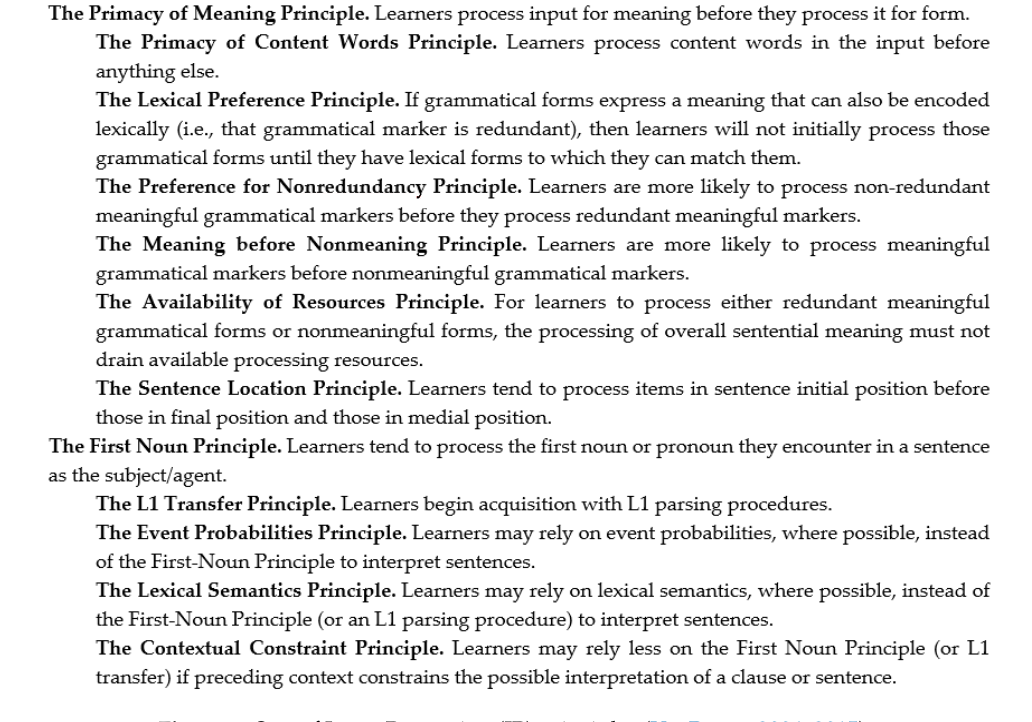
Figure 2. Sets of Input Processing (IP) principles (VanPatten 2004, 2015).